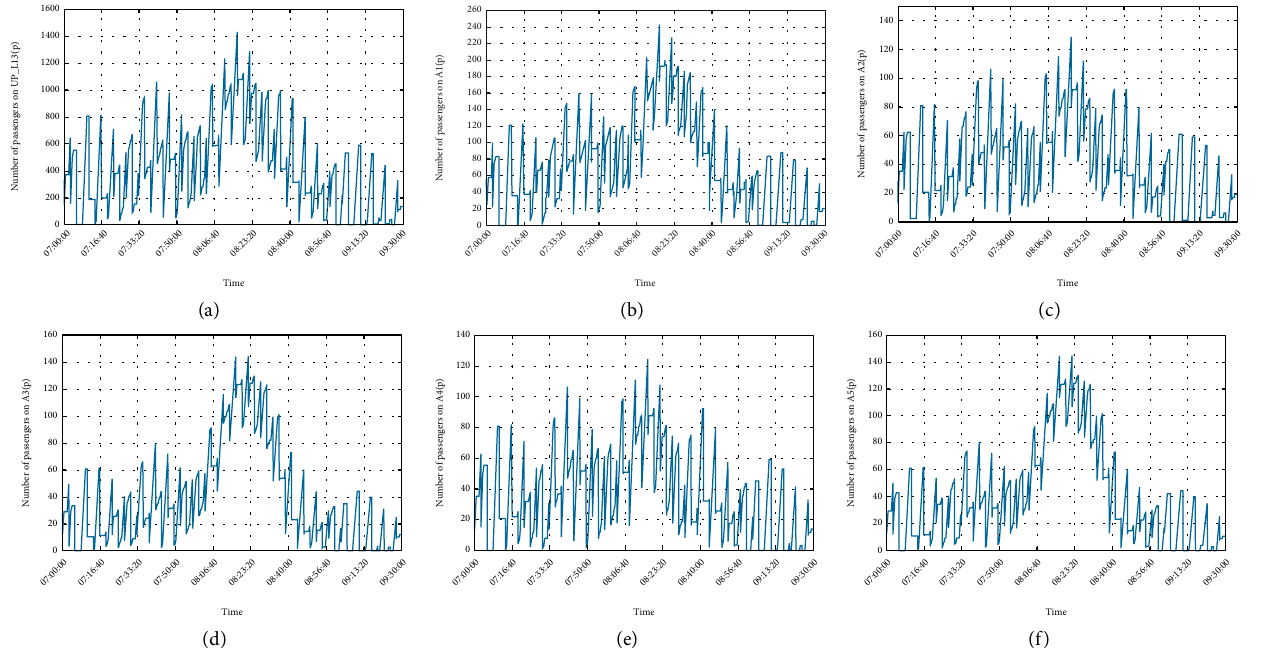
Figure 16: The change in the number of passengers of Line 13 and its subarea for the full simulation period. (a) UP_L13, (b) A1, (c) A2, (d) A3, (e) A4, and (f) A5.